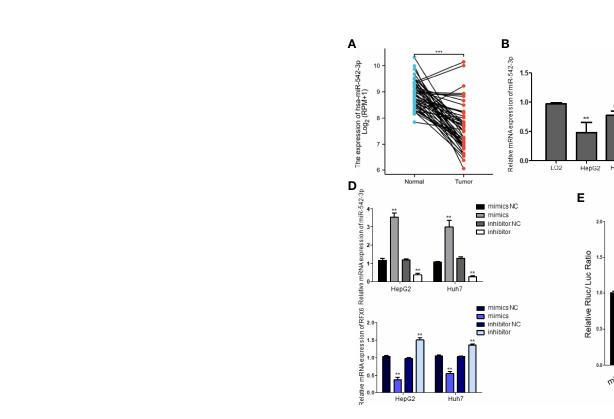
FIGURE 5 | miRNA-542-3p negatively regulates RFX6 and positively correlates with the prognosis of human hepatocellular carcinoma. (A) The comparison of the expression level of miR-542-3p in human hepatocellular carcinoma ( n = 374) and tumor adjacent normal tissues ( n = 50) in the TCGA database, ***p < 0.001. (B) The expression of miR-542-3p was signi fi cantly reduced in liver cancer cells. Data were represented as mean ± standard deviation (SD), n = 3, ** p < 0.01. (C) Log-rank (Mantel – Cox) survival test of hepatocellular carcinoma patients based on the levels of miR-542 (low expression n = 100, high expression n = 272), and p -values were indicated. (D) Alteration of miR-542-3p expression inversely correlated with the levels of RFX6 mRNA. Data were represented as mean ± standard deviation (SD), n = 3, ** p < 0.01. (E) miR-542-3p targeted with the predicted sites within the 3 ′ UTR of RFX6 and mutation of the predicted target sites rescued the inhibitory effects of RFX6. Data were represented as mean ± standard deviation (SD), n = 3, ** p < 0.01.